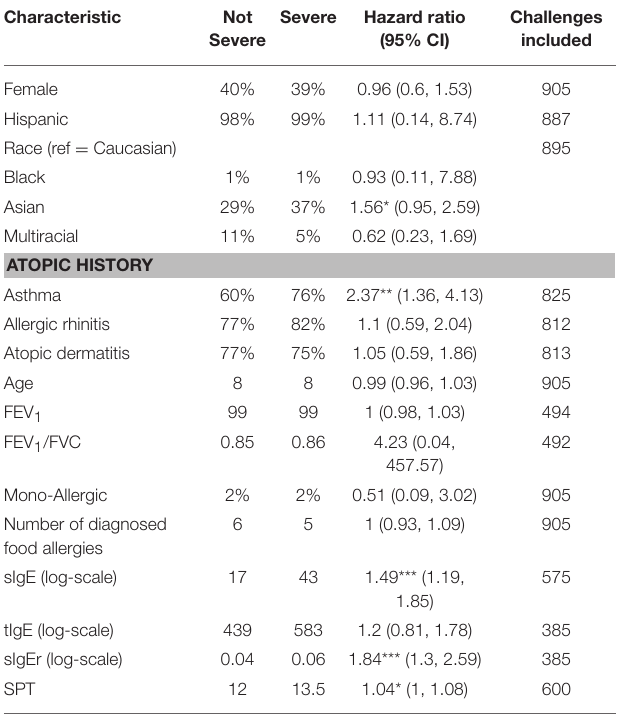
TABLE 5 | Univariate associations of